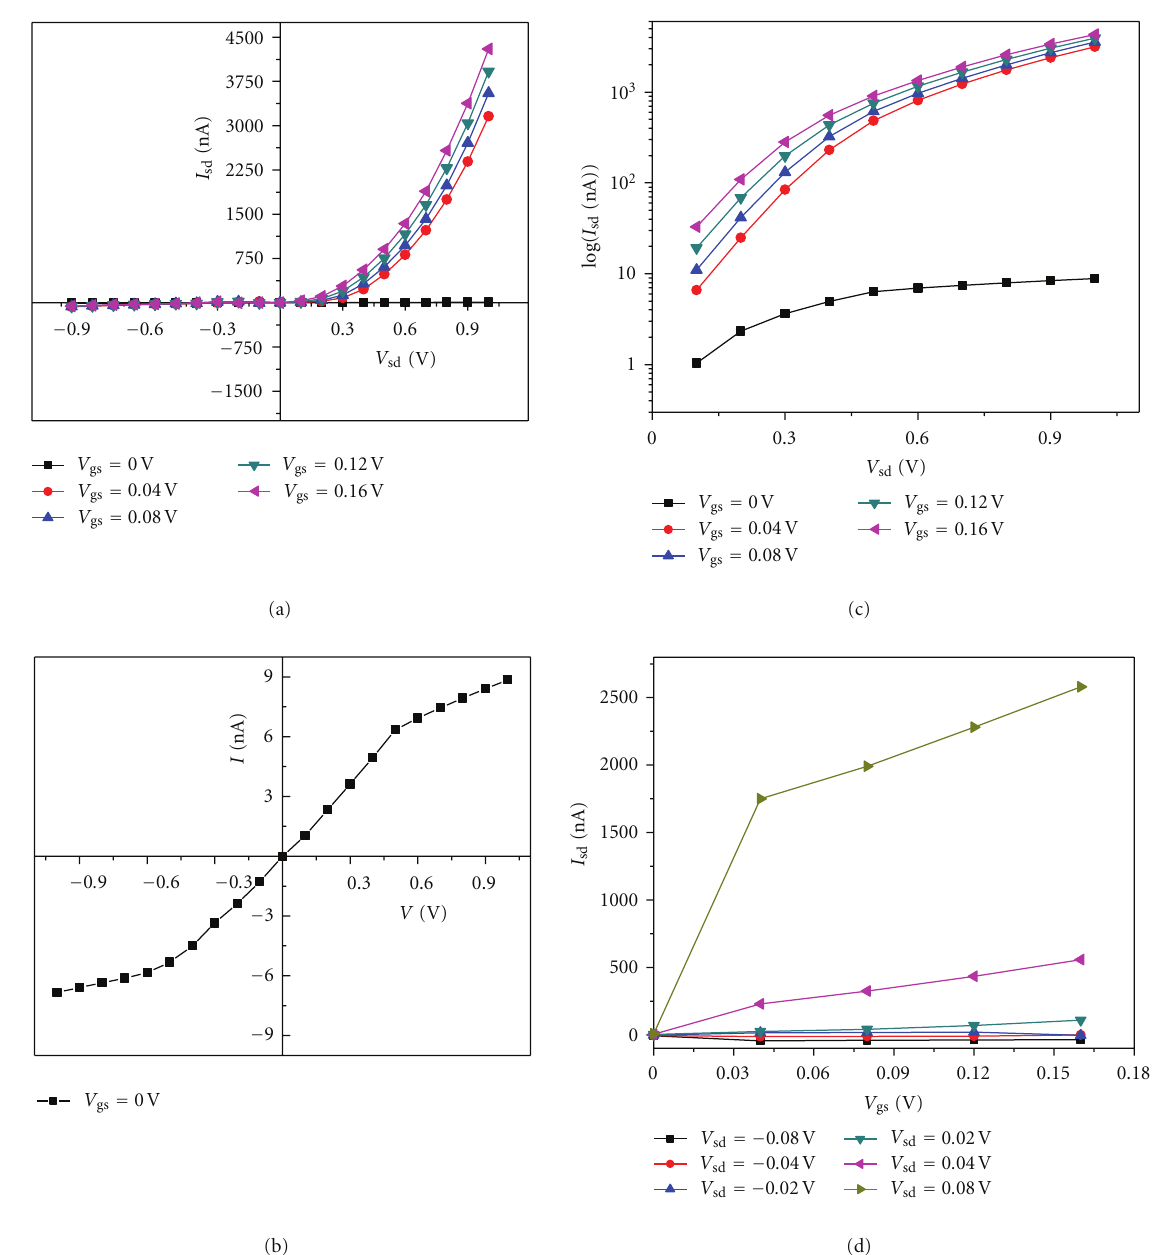
Figure 10: (a) I sd - V sd characteristic of anodized Ti nanowires as a NWFET, (b) the magnified I sd - V sd plot for zero gate voltage in forward and reverse bias, (c) logarithmic plot corresponding to (a), (d) transfer characteristics of nanowire-FET at di ff erent source drain voltages ( V sd